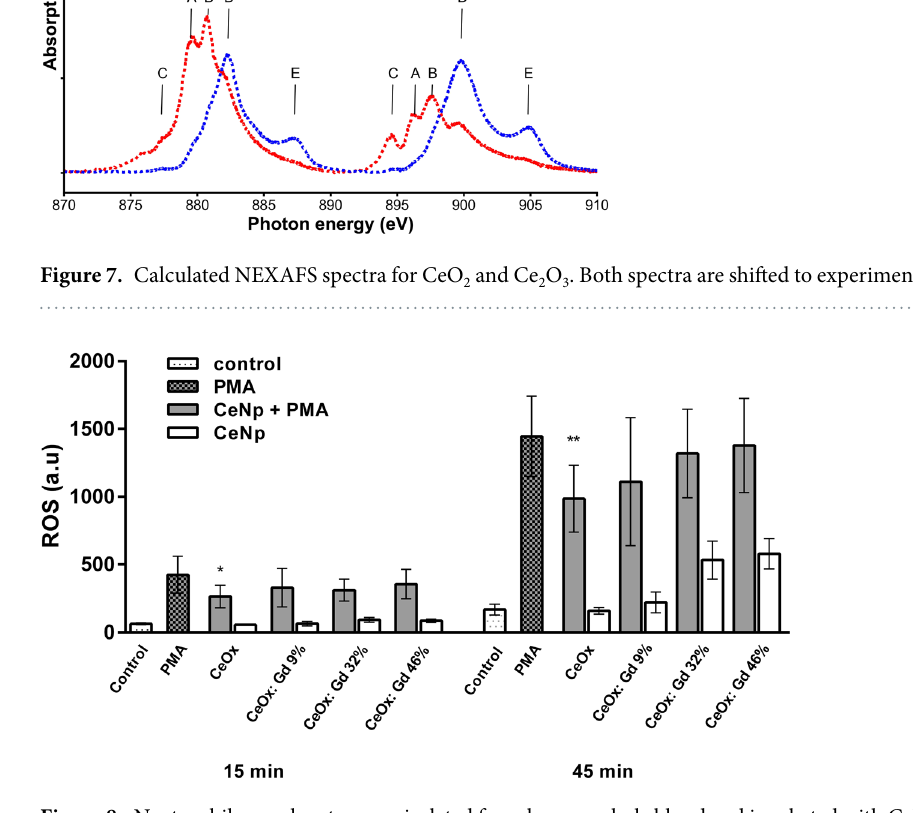
Figure 8. Neutrophil granulocytes were isolated from human whole blood and incubated with CeNPs in presence or absence of PMA (1 µ M). The CeNPs concentration were set to 50 µ g/ml of cerium for all nanoparticle samples. ROS production was measured using DCF-DA for 60 minutes. N = 4–8, minimum duplicate samples. ROS production (a.u) ± S.E.M. * P ≤ 0.05, ** P ≤ 0.01 (paired t-test, GraphPad Prism